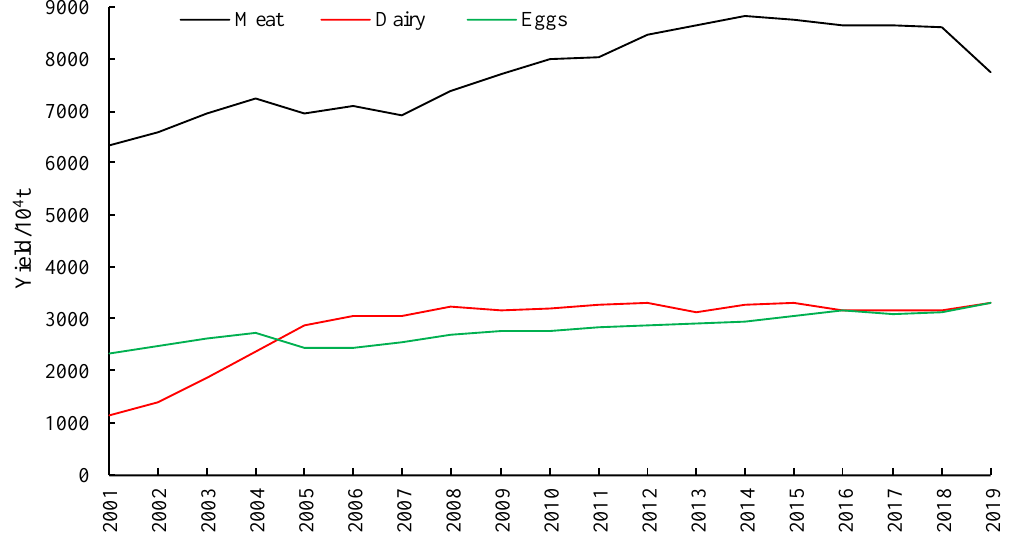
Figure 3. Changes of meat, egg, and milk yield in China.